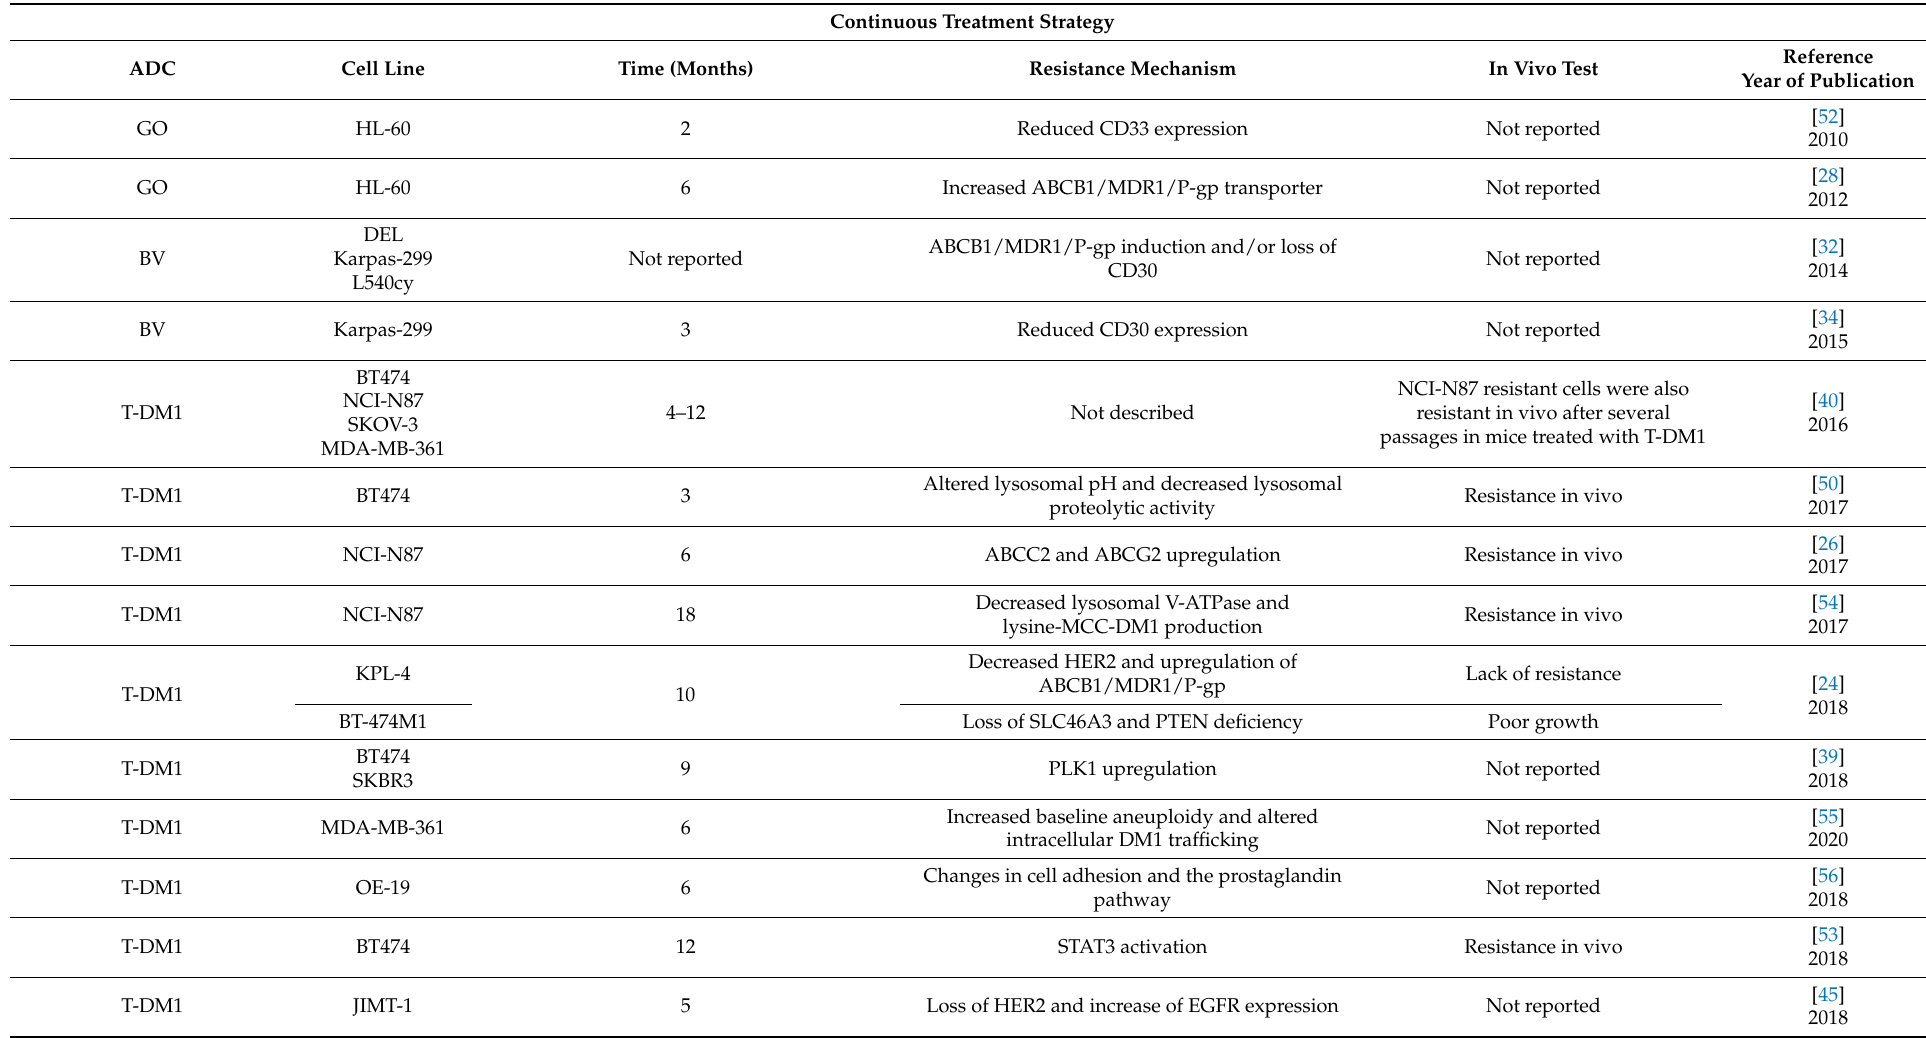
Table 2. Models of secondary resistance to